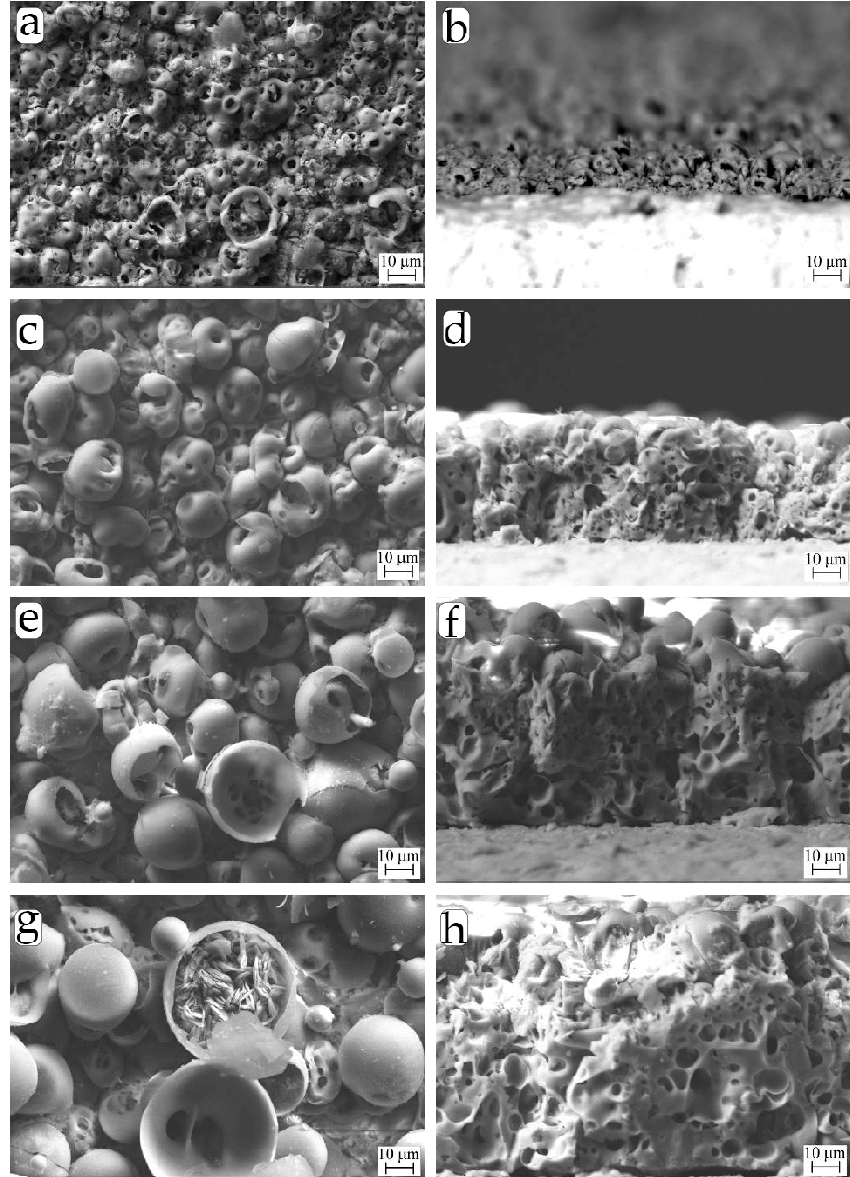
Figure 1. Scanning electron microscopy (SEM) images of the surface ( a , c , e , g ) and cross-section ( b , d , f , h ) of the CaP coatings deposited at 150 V ( a , b ), 200 V ( c , d ), 250 V ( e , f ), and 300 V ( g , h ).